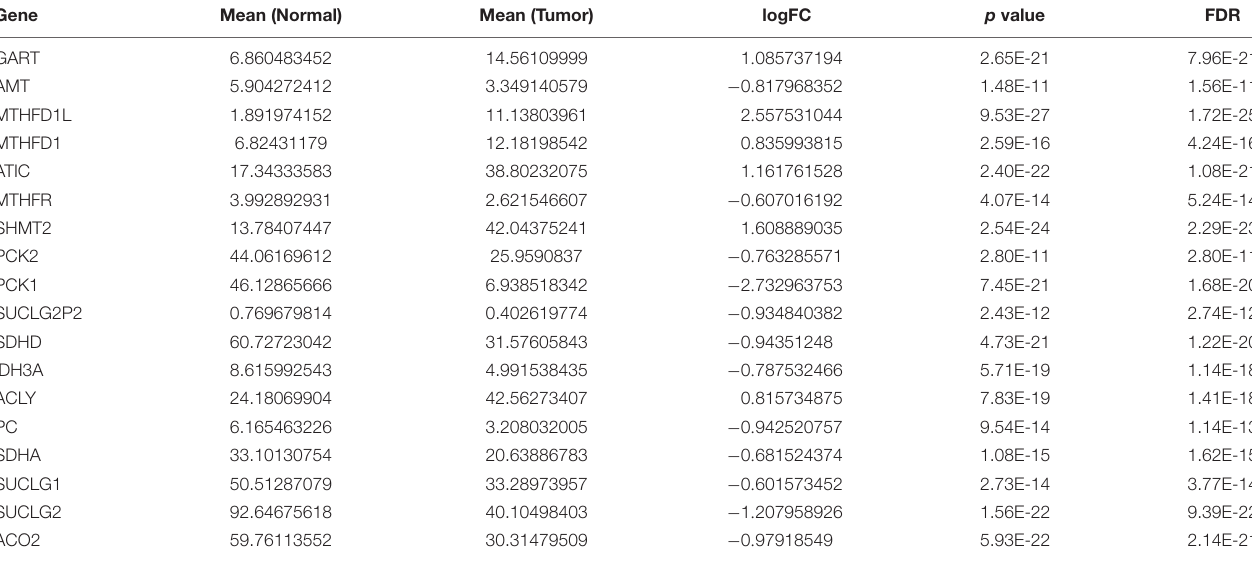
TABLE 1 | Eighteen DEGs in the TCA and one carbon metabolism pathway from TCGA datasets between tumor and normal tissues. Gene Mean (Normal) Mean (Tumor) logFC p value